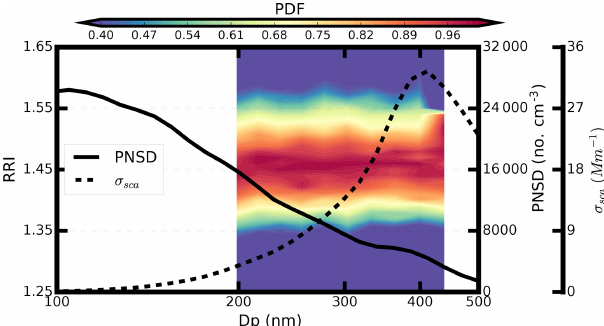
Figure 5. The measured probability of the size-resolved RRI (shaded portion), the measured mean PNSD (the solid line) and the mean scattering size distribution (the dotted